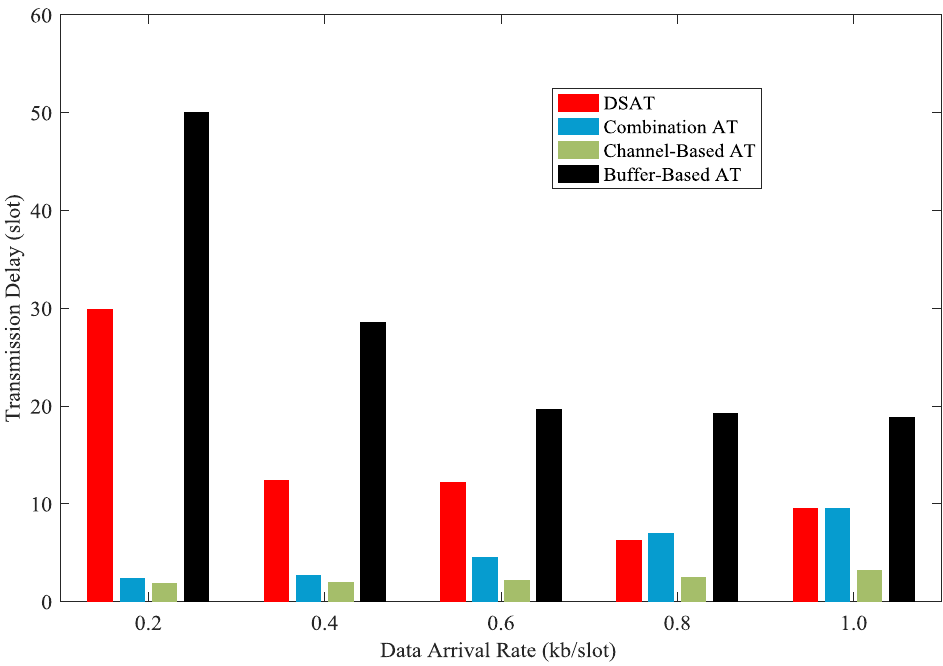
Figure 28. Average transmission delay for comparative strategies (Data